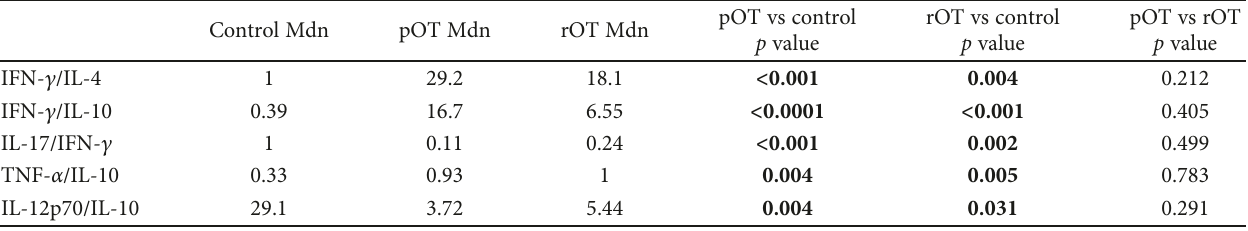
Figure 3: Cytokine patterns of the T and the chemokine IL-8 comparing immune mediator concentrations in aqueous humor of patients with pOT ( n = 21 ) and rOT ( n = 30 ) and the control group ( n = 11 ). Table 4: All fi ve cytokine ratios (IFN- γ /IL-4, IFN- γ /IL-10, IL-17/IFN- γ , TNF- α /IL-10, and IL12p70/IL-10) indicate a dominant T immune